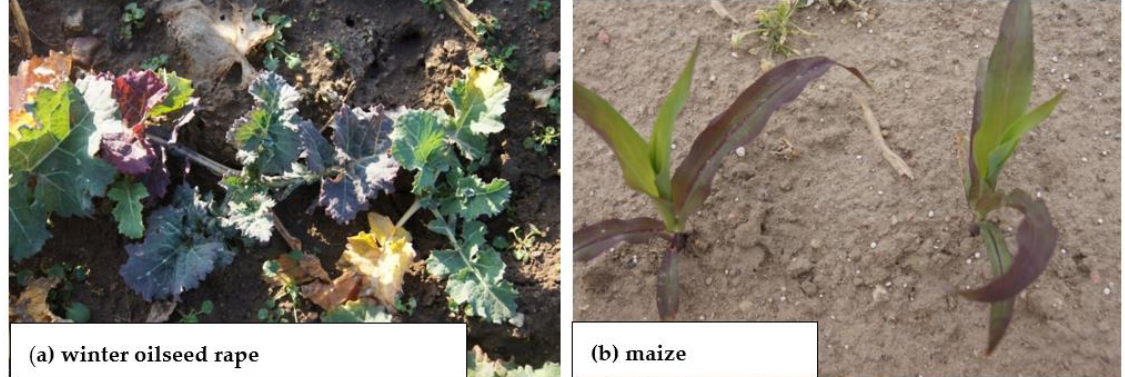
Figure 6. Symptoms of phosphorus deficiency in two different species grown in humid climate zone: ( a ) violet plants of winter oilseed rape are not able to conduct photosynthesis); and ( b ) violet maize plants at BBCH 33 often fail to develop a cob. (Photos by W. Grzebisz.)